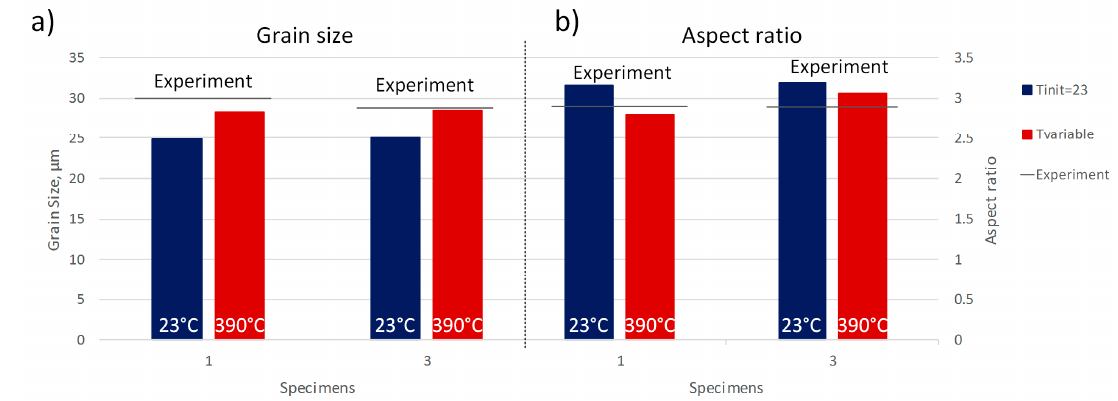
Figure 14. Grain size ( a ) and grain aspect ratio ( b ) predictions for Specimens 1 and 3 with variable initial substrate temperatures (23 °C blue, 390 °C red); average experimental data are presented by horizontal bars.